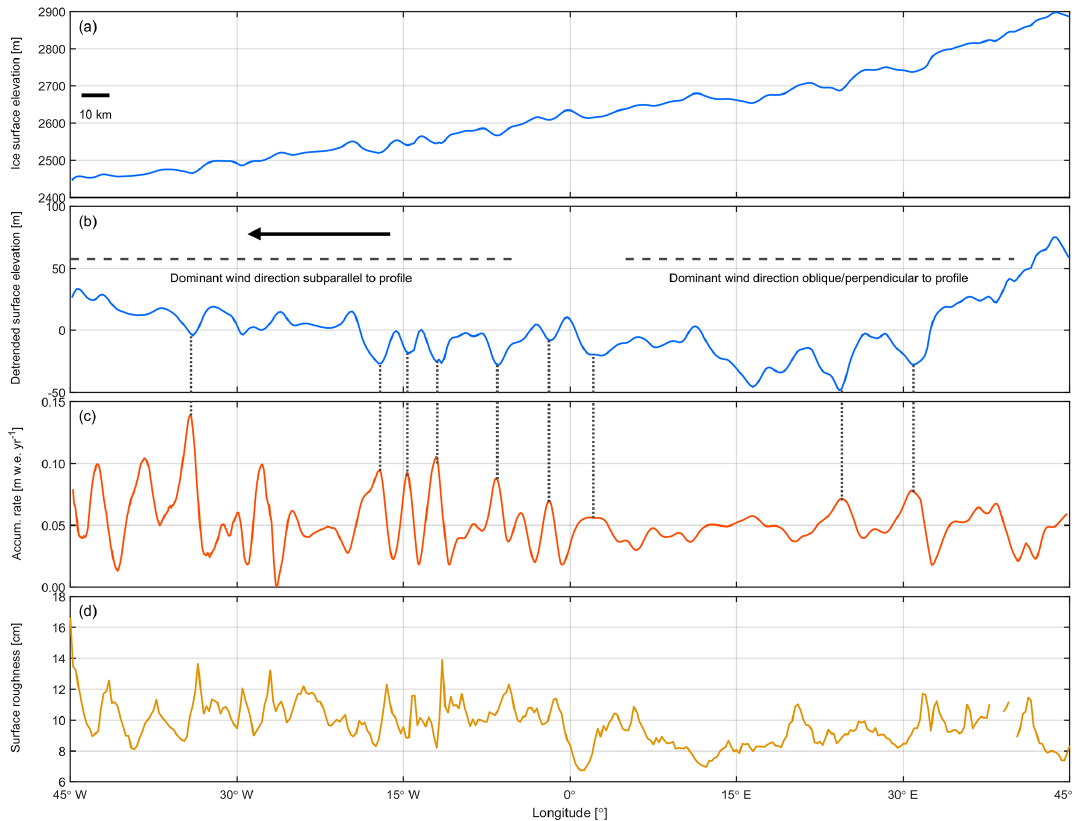
Figure A2. (a) Ice surface elevation at 88 ◦ S between 45 ◦ W and 45 ◦ E from ATM laser altimetry. (b) Ice surface elevation with linear trend removed. (c) Snow accumulation rate. Several prominent peaks that spatially correlate with topographic depressions are marked by grey dashed lines. (d) ATM-derived ice surface